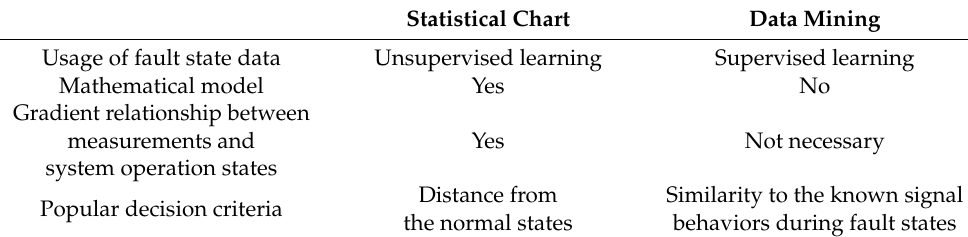
Table 1. Classification of fault detection and diagnosis (FDD)